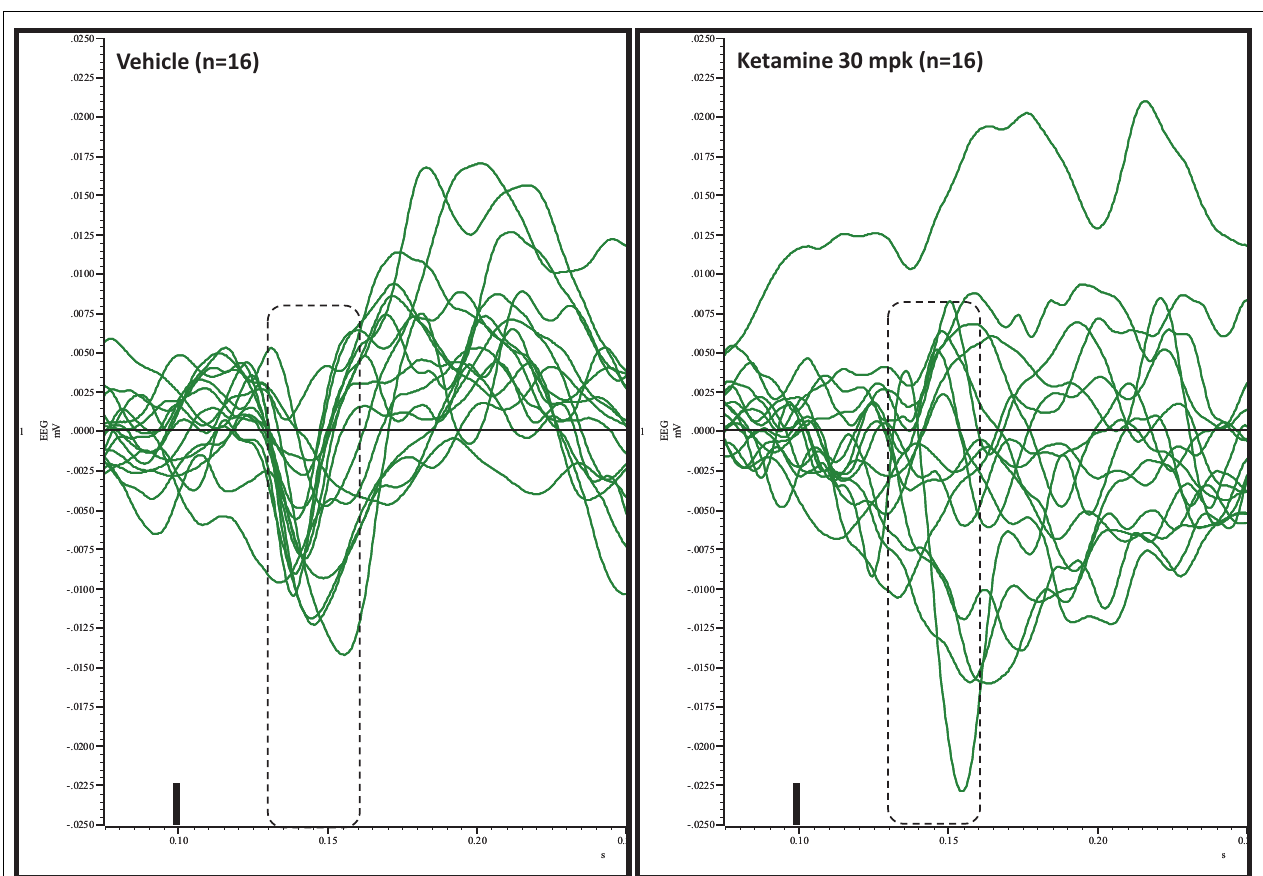
FIGURE 5 | Overlay of difference waves after vehicle or ketamine approximately 10 min after treatment . A consistent pattern of negativity is apparent after vehicle but not after ketamine.